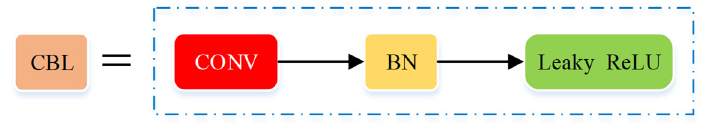
Figure 10. Structure of the CONV-BN-Leaky ReLU (CBL) module.